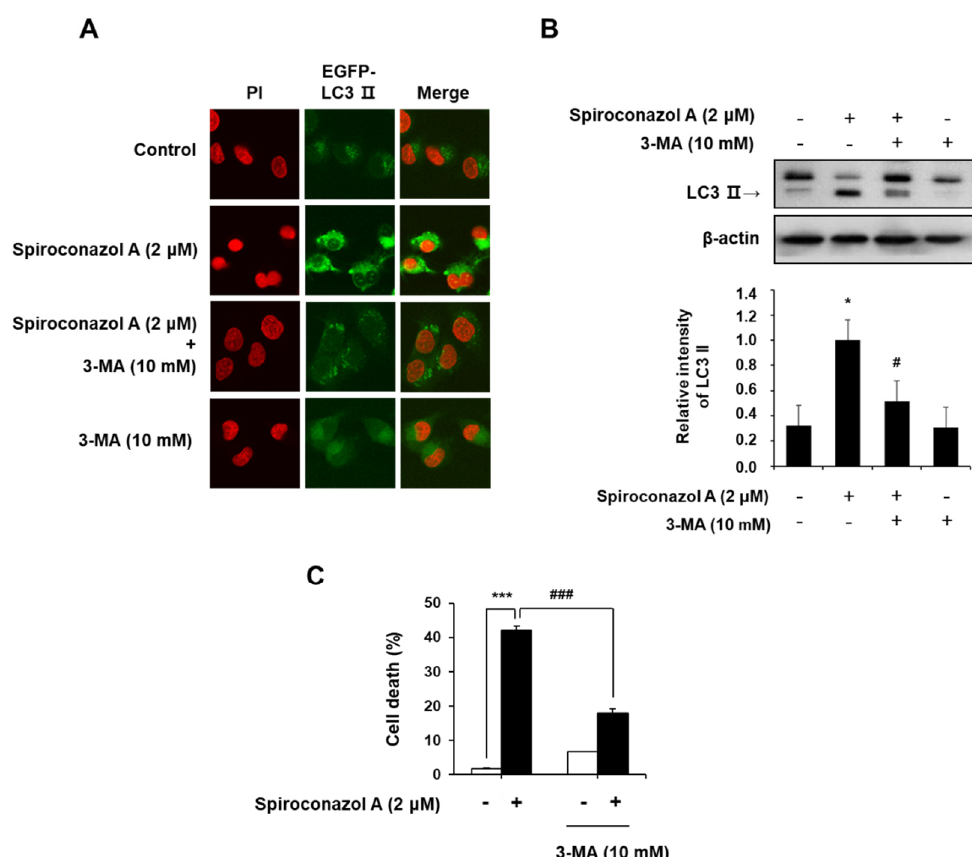
Figure 3. Cell death by spiroconazol A-induced autophagy. ( A ) The pEGFP-LC3-II-transfected A549 cells were treated with 2 µ M of spiroconazol A for 24 h; immunofluorescence of pEGFP-LC3-II was detected by confocal fluorescence microscopy. After pretreatment with 10 mM of 3-MA for 1 h, cells were treated with 2 μ M of spiroconazol A for 24 h and then examined by ( B ) Western blot analysis and ( C ) PI staining, respectively. Experiments were repeated at least three times, and data are ex- pressed as mean ± S.D. The relative optical density ratio was determined using a densitometric anal- ysis program (Bio-Rad Quantity One ® Software, version 4.6.3 (Basic), Bio-Rad Laboratories Inc., CA, USA), normalized to the internal control. * p < 0.05, *** p < 0.001 vs. untreated A549 cells and # p < 0.05, ### p < 0.001 vs. spiroconazol A-treated A549 cells, by the Student’s t -test.